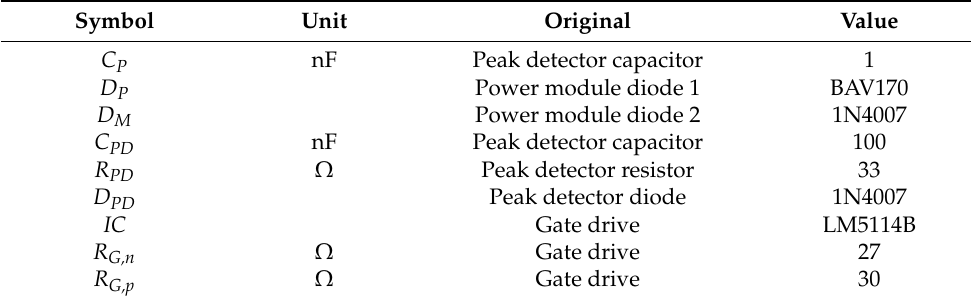
Figure 7. Voltage sequence of the synchronous rectifier. Table 7. Parameters in D-Mode GaN HEMT Synchronous Rectifier.